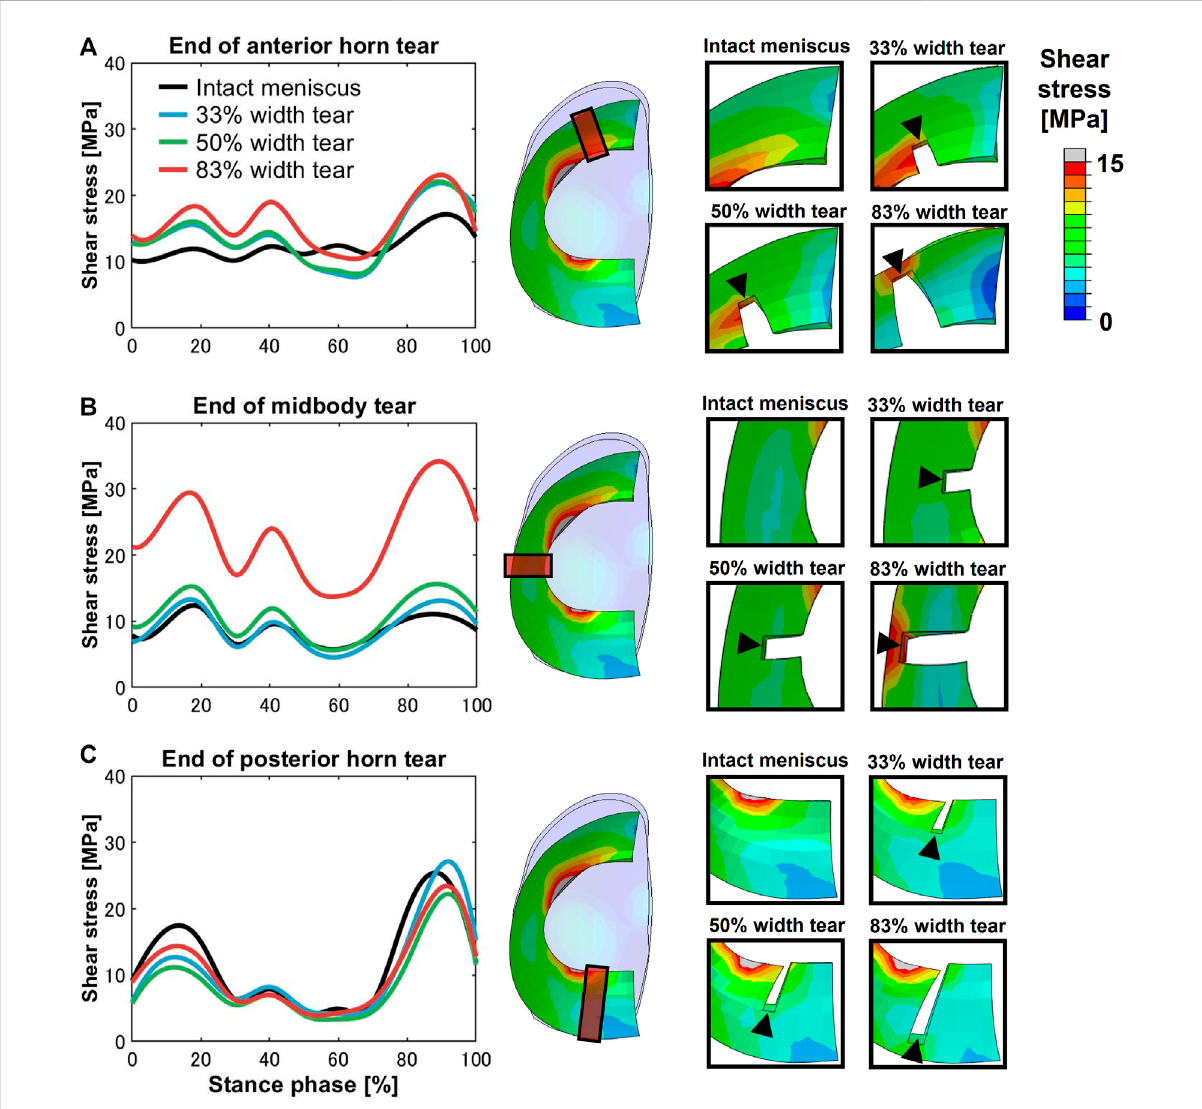
FIGURE 4 Shear stress differences on an intact meniscus and a meniscus with a medial radial tear at the ends of the tears. The left sub fi gures show the magnitude of stress at the (A) anterior horn, (B) midbody, and (C) posterior horn, involving an intact meniscus and 33%, 50%, and 83% width tears during the stance phase of the gait cycle. The right sub fi gures indicated the tear locations (orange box) at the anterior horn, midbody, and posterior horn and enlarged views of the tear